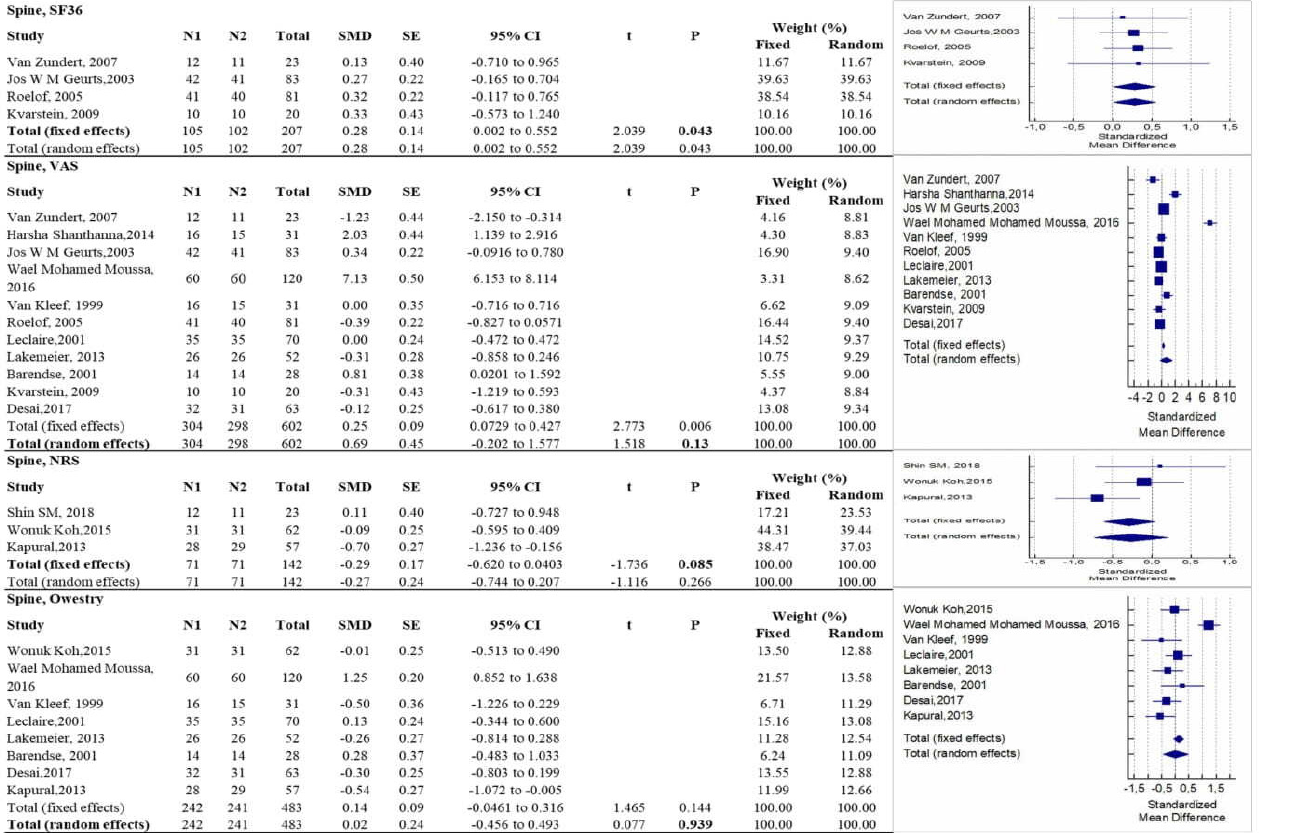
Figure 5. Forest plots showing intervention effects on the knee: WOMAC, OXFORD, and VAS outcomes. The use of fixed or random effects (bold) is chosen based on the results of the Higgins’